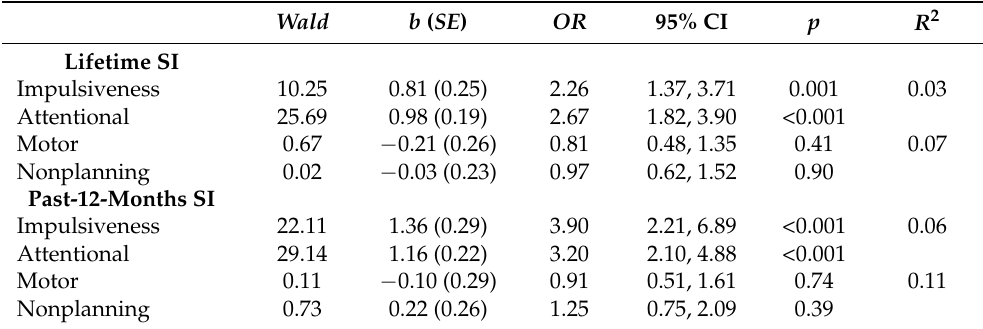
Table 3. Binary logistic-regression analysis examining impulsivity as a predictor of suicidal